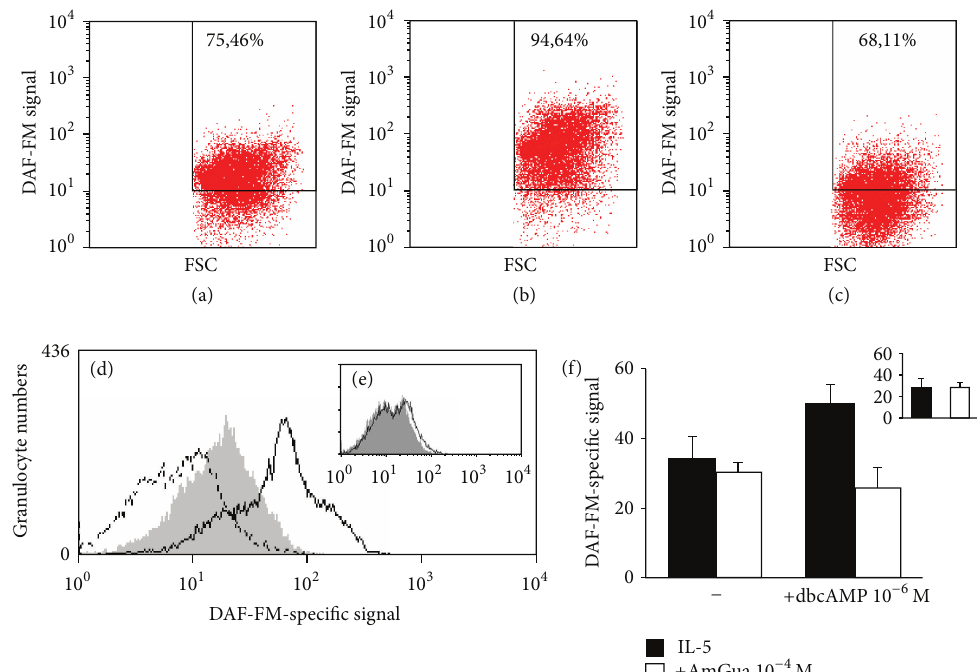
Figure 6: NO is generated through iNOS in response to dibutyryl cAMP in the presence of IL-5. Bone-marrow cells from wild-type BALB/c ((a)–(c)) or C57BL/6 mice ((d) and (f)) or iNOS-deficient (iNOS KO) mutant C57BL/6 mice ((e) and insert in (f)) were preincubated with DAF-FM in HBSS/PhR- containing 100 𝜇 M L-arginine and further incubated for 8 h at 37 ∘ C in this medium, in the presence of IL-5, alone or associated with 10 −6 M dibutyryl cAMP (dbcAMP), aminoguanidine (AmGua), 10 −4 M, or combinations of these agents. Cells were harvested and incubated with DAF-FM and NO-specific fluorescence was monitored by flow cytometry with a gate in the granulocyte region. (a)–(c): dot-plot of NO production as a function of FSC for cells in the gated region, in cultures exposed to IL-5 alone (a) or associated with dbcAMP (b)orwithdbcAMPplusaminoguanidine(c).Numbersindicatethe%ofthegatedcellsinthepositivezone.(d)-(e):histogramoffluorescence intensities ( 𝑥 -axis) as a function of cell numbers ( 𝑦 -axis), from one representative experiment out of 3. Gray profile: IL-5 alone. Continuous line: IL-5 plus dbcAMP. Broken line: IL-5 plus dbcAMP and AmGua (wild-type controls only). (f) and insert: mean fluorescence intensities (mean + SEM; 𝑛 = 3 ) from the same experiments as in (d)-(e), showing NO-specific fluorescence in wild-type control (f) and iNOS-deficient cultures (insert); (f), cultures exposed to IL-5 alone (black bar on the left) or associated with AmGua alone (white bar on the left, wild-type controls only), with dbcAMP (black bar on the right) or dbcAMP plus AmGua (white bar on the right, wild-type controls only); insert, cultures exposed to IL-5 alone (black bar) or associated with dbcAMP (white bar). (f): 𝑃 = 0.043 for the indicated